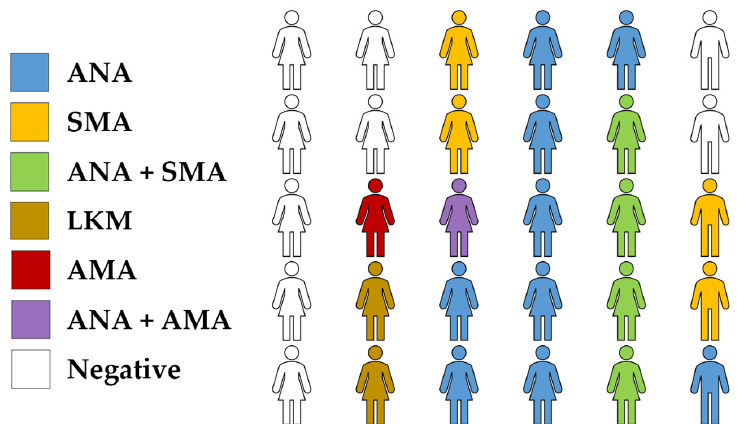
Figure 1. Characteristics of the study participants based on sex and serologic profile. ANA: Antinu- clear antibodies; SMA: anti-smooth muscle antibody; LKMs: liver–kidney microsomal antibodies; AMA: antimitochondrial antibody.